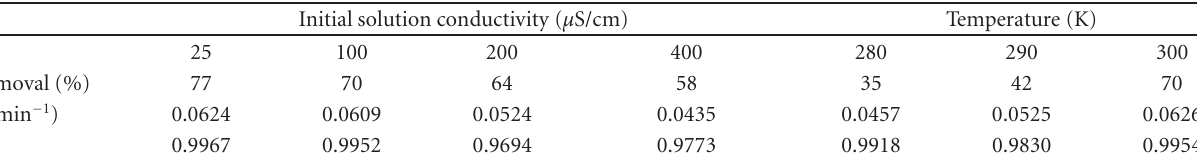
Table 2: Cu 2+ removal, the reaction rate constant k and correlation coe ffi cients r 2 of kinetic equation at di ff erent initial solution conductivities and di ff erent solution temperatures.